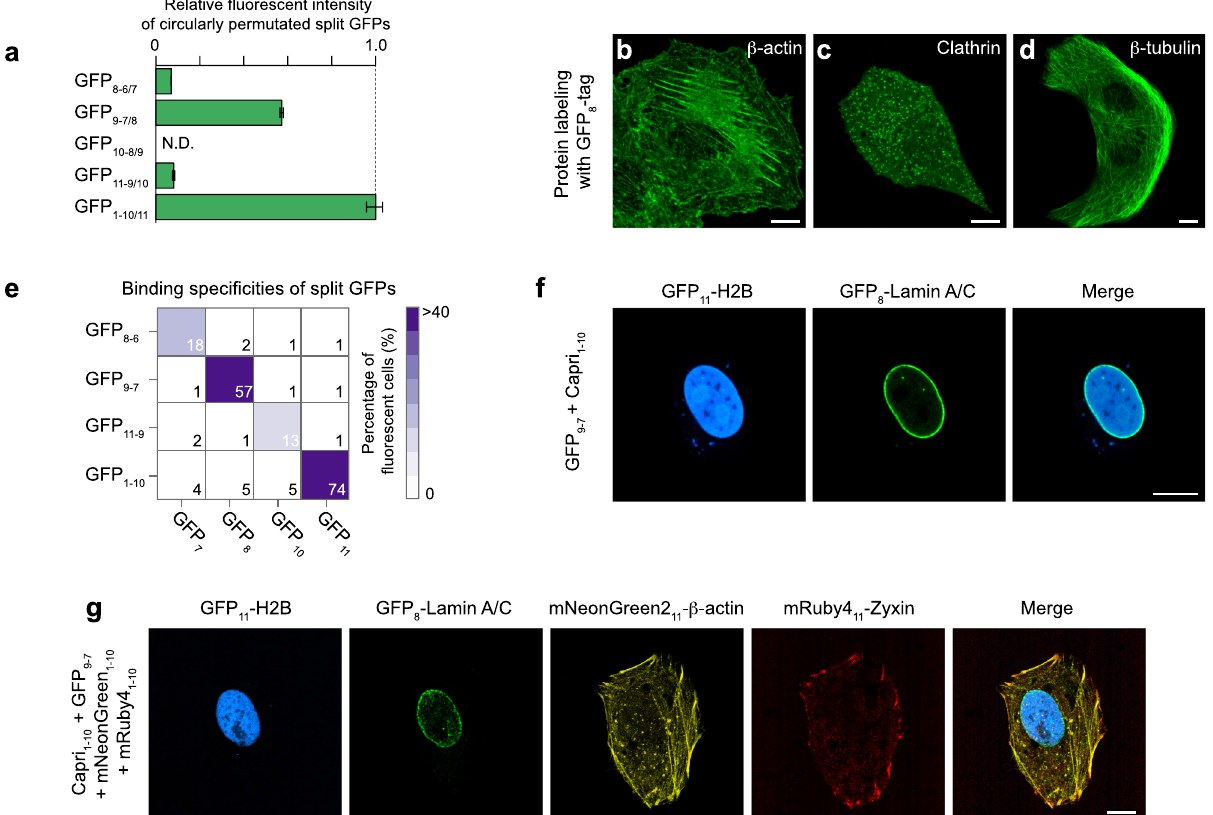
Fig. 4 Multiplexed labeling of cellular proteins in human cells. a Fluorescence intensity of HEK 293T cells expressing actin labeled with circularly permutated split GFP variants, measured by fl ow cytometry (see also Supplementary Fig. 16). n = 698 cells for GFP 8-6/7 ; n = 7792 for GFP 9-7/8 ; n = 274 for GFP 11-9/10 ; n = 11017 for GFP 1-10/11 . Error bars are SEM. b – d Confocal images of HeLa cells co-expressing GFP 9-7 with GFP 8 fusions; β -actin ( b ), Clathrin light chain ( c ), and β -tubulin ( d ). e The binding speci fi cities of GFP 8-6/7 , GFP 9-7/8 , GFP 11-9/10 , and GFP 1-10/11 were characterized by fl ow cytometry (see also Supplementary Fig. 17). f Dual-color fl uorescence images of a U2OS cell expressing two different fusions, GFP 11 -H2B and GFP 8 -Lamin A/C. g Four-color images of a U2OS cell co-expressing GFP 11 -H2B, GFP 8 -LaminA/C, mNeonGreen2 11 - β -actin, and mRuby4 11 -Zyxin with GFP 1-10 , GFP 9-7 , mNeonGreen2 1-10 , and mRuby4 1-10 . Scale bars, 10 μ